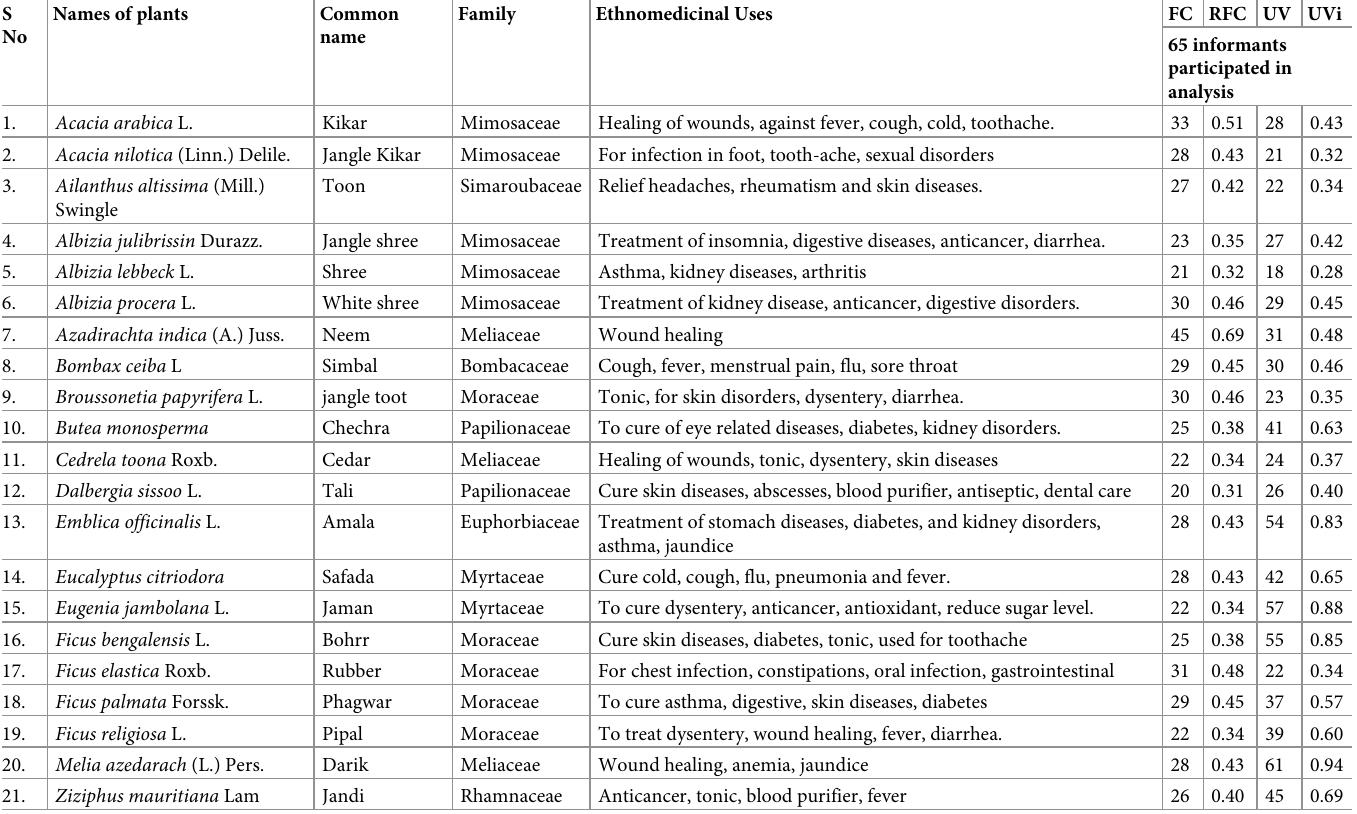
Table 5. The use value index (UVI) and Relative frequency of citation (RFC) of the most commonly used medicinal plants by the local people of different areas of SMR of District Bhimber (AJK), Pakistan (Note: 65 informants participated in this specific